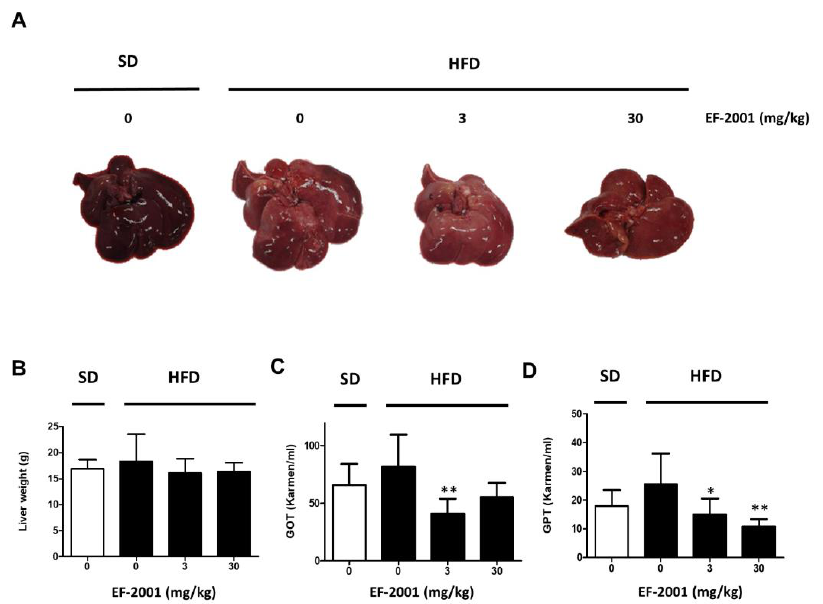
Figure 1. Effects of EF-2001 oral administration on high fat diet (HFD)-induced accumulation of liver tissue and level of glutamic oxaloacetic transaminase/glutamic pyruvic transaminase (GOT/GPT) in serum of obese rats. Male rats were divided into standard diet (SD) or HFD groups and were orally administered refined water or 3 mg/kg or 30 mg/kg EF-2001 in water (n = 6 rats/group). Gavage was continued for 6 weeks. After six weeks of feeding, rats were fasted for 12 h, and then, blood samples were collected. ( A ) Effects of EF-2001 on the accumulation of liver tissue of HFD-induced hepatic steatosis. Pictures were taken for livers of each group. ( B ) Effects of EF-2001 on the liver weight of rats fed SD and HFD for 6 weeks. To investigate the weight of liver tissue, the rats were sacrificed, and liver tissue weight was measured. ( C ) Effects of EF-2001 on GOT in HFD-induced hepatic steatosis. ( D ) Effects of EF-2001 on GPT in HFD-induced hepatic steatosis. Data was analyzed with liver tissue weight per body weight. Data are represented as the mean ± SEM. (n = 6); * p < 0.05 and ** p < 0.01 vs. HFD-fed rats alone without